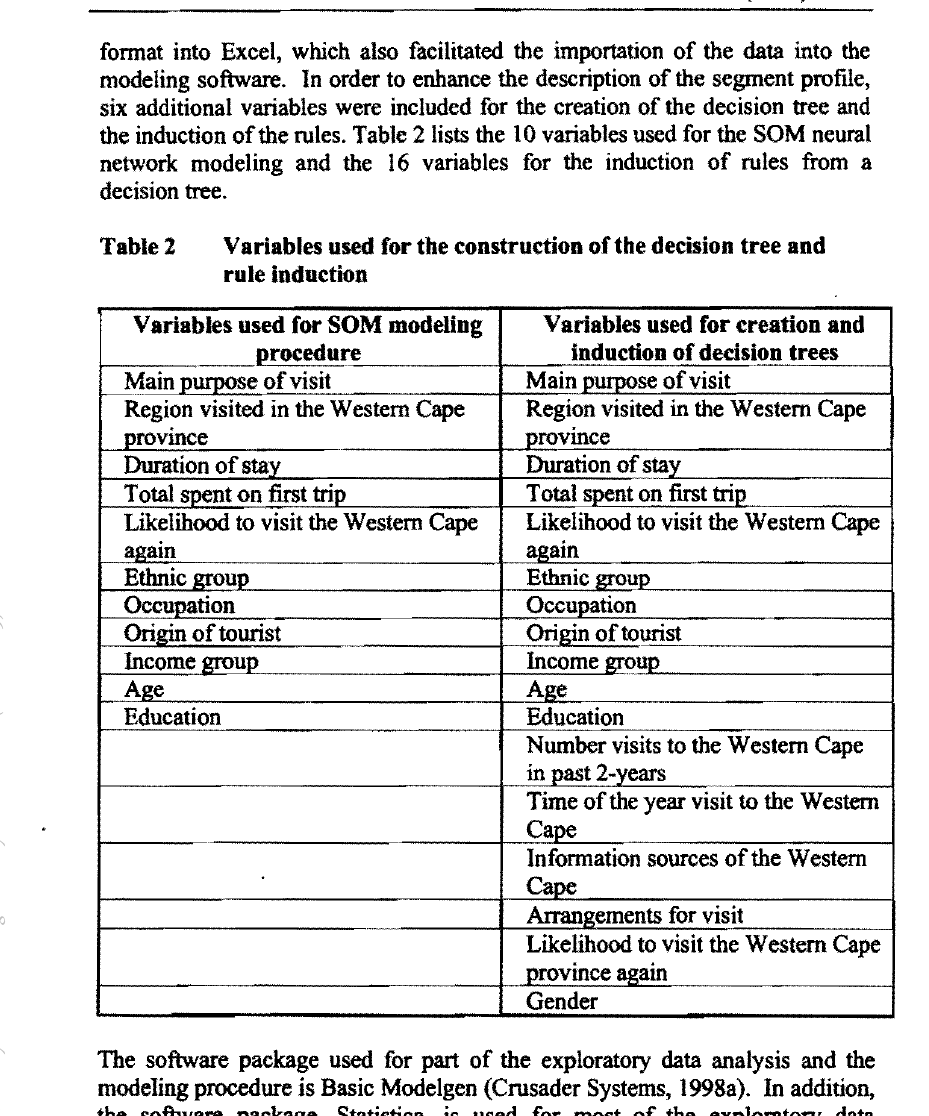
Variables used for the construction of the decision tree and rule Induction Variables used for SOM modeling Variables used for creation